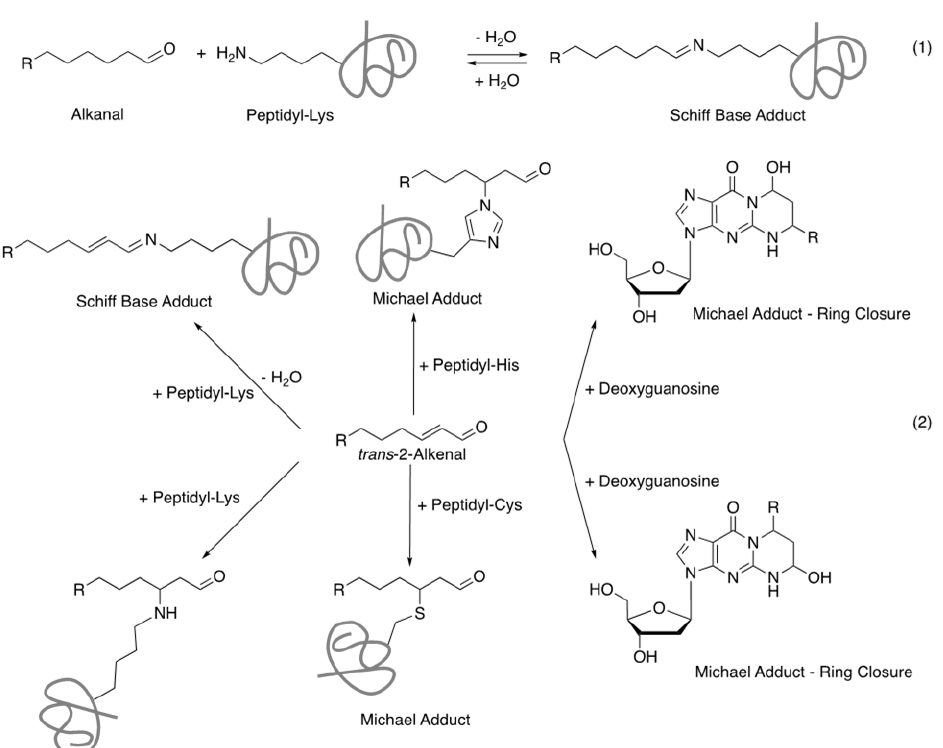
Figure 5. Adduct formation with aldehydes. Schiff base formation occurs between alkanal (1) or trans -2-alkenal (2) and the ϵ -amino group of the lysine side chain; Michael adducts formation occurs between trans -2-alkenal with nucleophilic amino acid side chains of peptides and proteins such as lysine, histidine, and cysteine residues, as well as nucleic acids (here deoxyguanosine is shown as an example) (2). cis -4-Decenal only forms Schiff base adducts. The Schiff base products are less stable than Michael adducts as they can easily undergo hydrolysis or further nucleophilic addition of nucleophilic amino acid side chains.